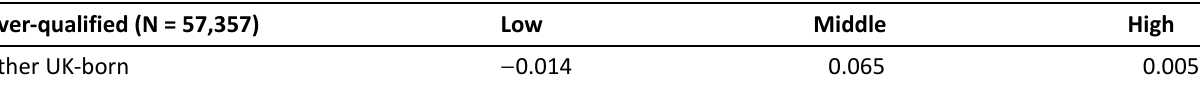
Table A8. (Cont.) Robustness tests for men: binary logistic regression of being employed rather than unemployed, and under- and over-qualification using mode.